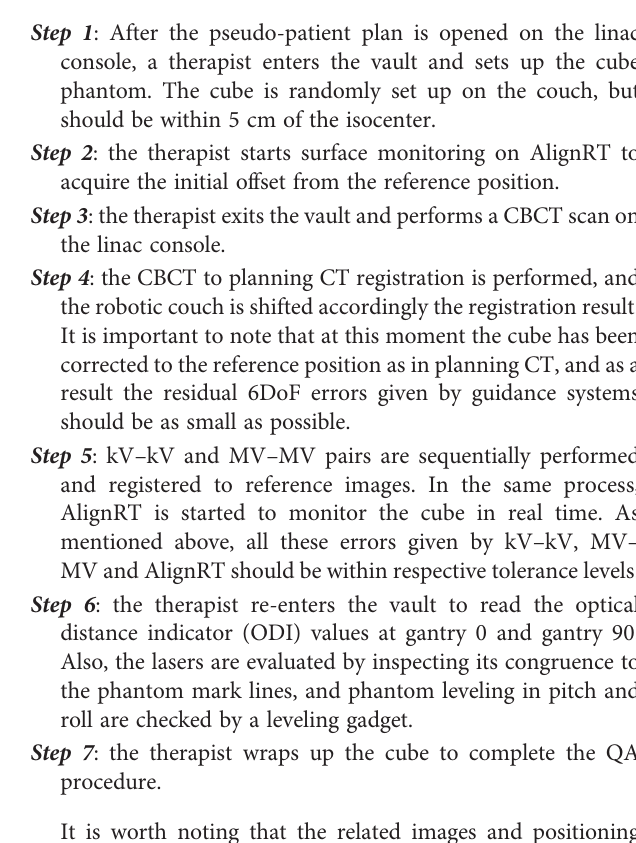
Figure 1C . In the meantime, image veri fi cations of CBCT, kV – kV and MV – MV pairs were also added in the plan.